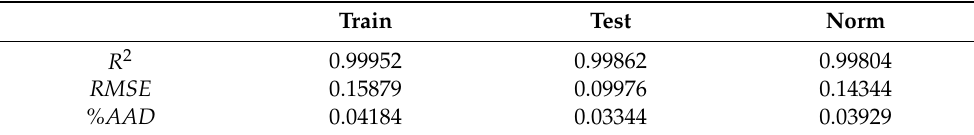
Table 4. Summary of the statistical results of the ANN using experimental data.